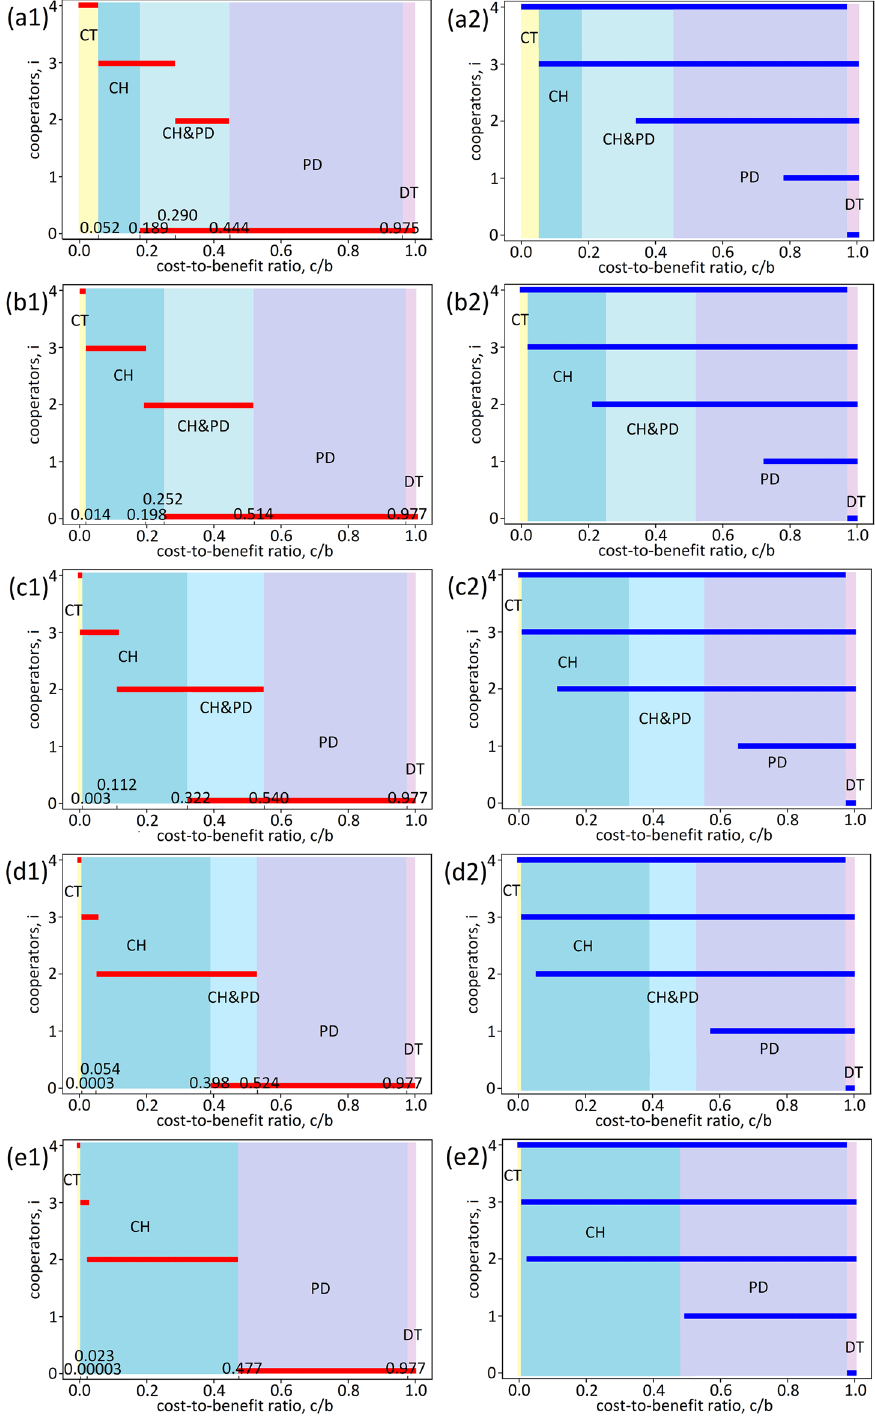
Figure 3. Equilibria and optimal strategies of the four-player weightlifting game. Nash equilibria ( a1 , b1 , c1 , d1 , e1 ) and Pareto optimal strategies ( a2 , b2 , c2 , d2 , e2 ). ( a1 , a2 ) µ = 60 . ( b1 , b2 ) µ = 70 . ( c1 , c2